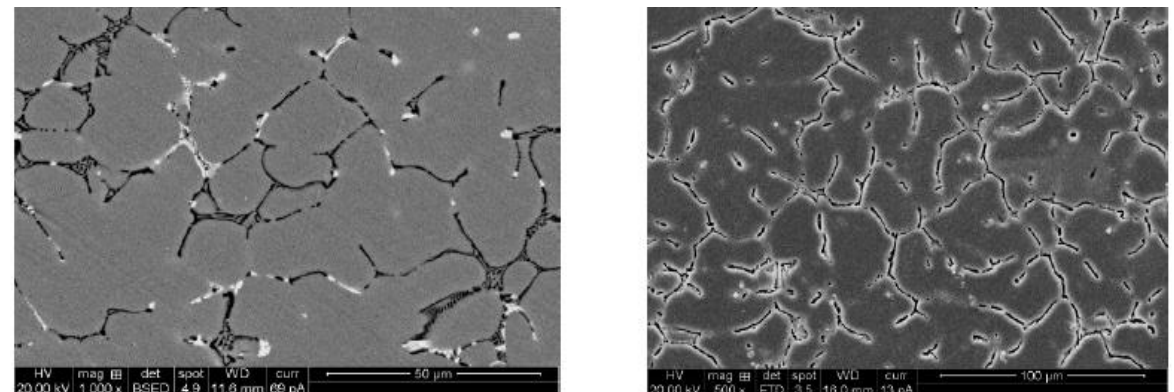
Figure 5. Micrographs of 6061Al-Al 2 O 3 composite.